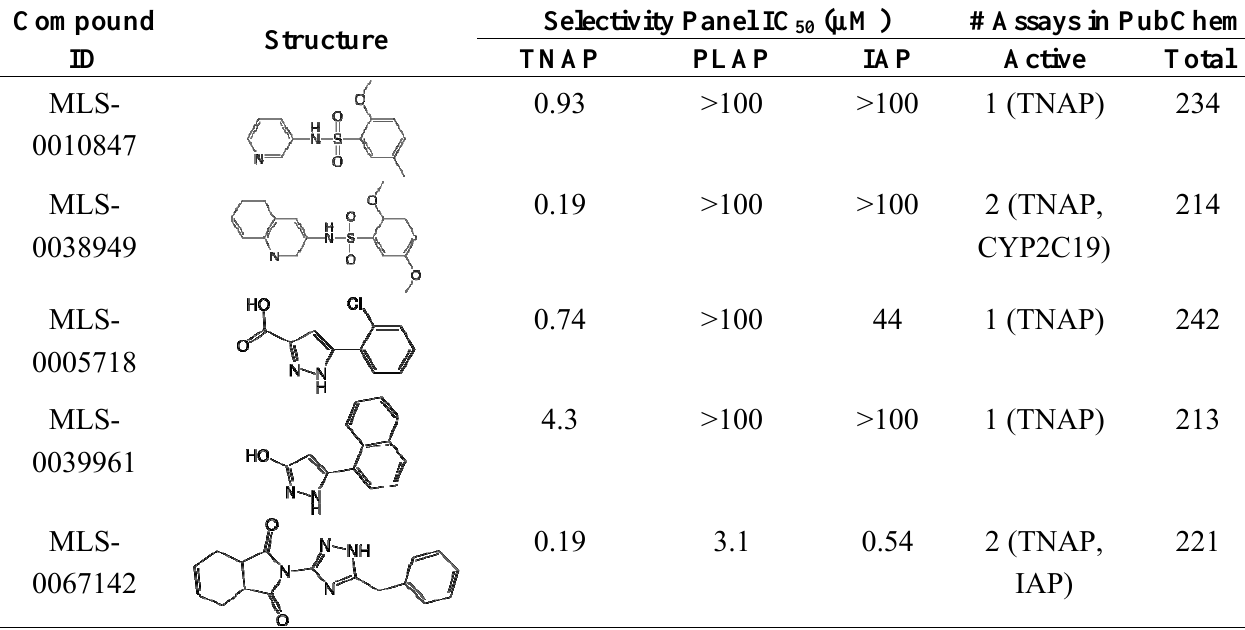
Table 4. Selectivity of Primary TNAP Scaffolds against Other Alkaline Phosphatases.